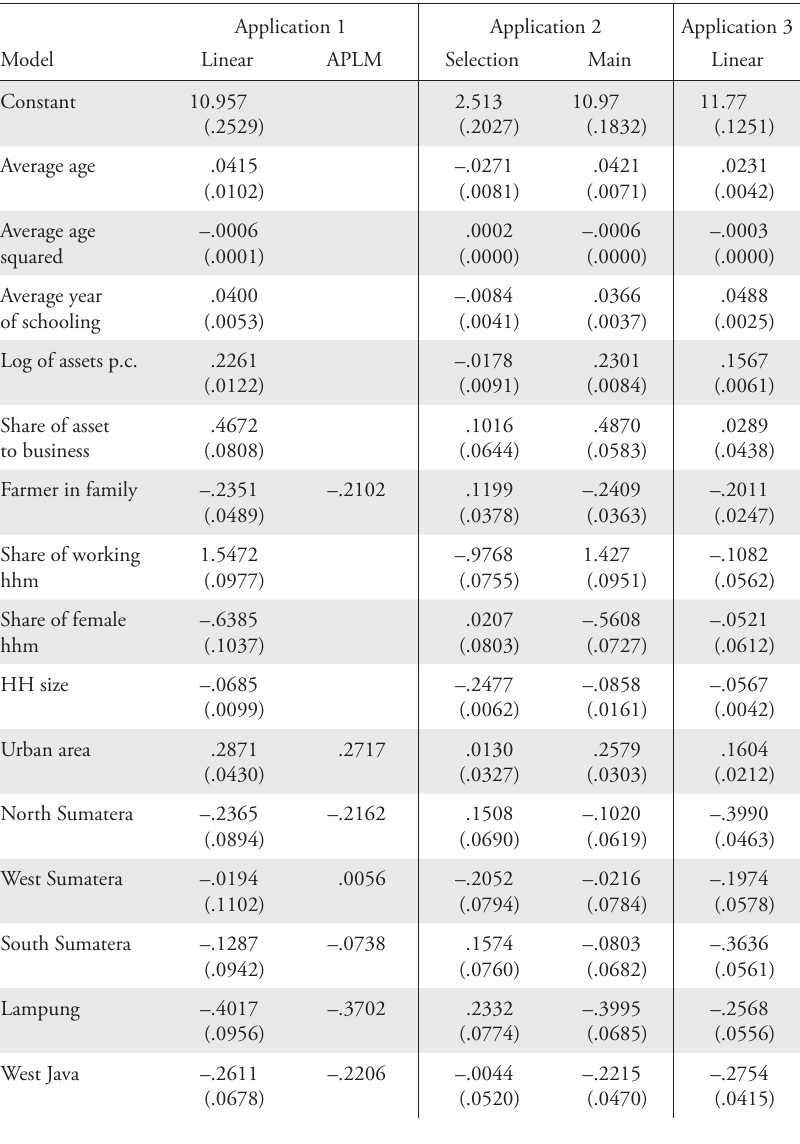
Table 7: Estimated regression coefficients for log(income) under different